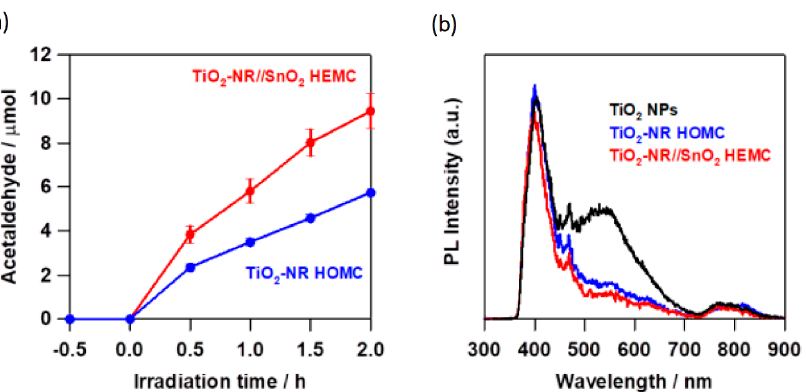
Figure 4. ( a ) Comparison of the photocatalytic activities of TiO 2 ‐ NR//SnO 2 HEMCs ( t HT = 8 h) and TiO 2 ‐ NR HOMCs ( t HT = 8 h) for gas ‐ phase oxidation of ethanol under UV ‐ light irradiation ( λ = 365 nm, I = 2.0 mW cm − 2 ). ( b ) PL spectra were measured for TiO 2 ‐ NR//SnO 2 HEMCs, TiO 2 ‐ NR HOMCs, and TiO 2 NPs for comparison at 77 K with an excitation wavelength of 340 nm. The figure is taken from Reference [32] (reproduced with permission from Akita, A.; Sugita, S.; Naya, S.; Tada, H., Catal. Commun. ; published by Elsevier, 2021).